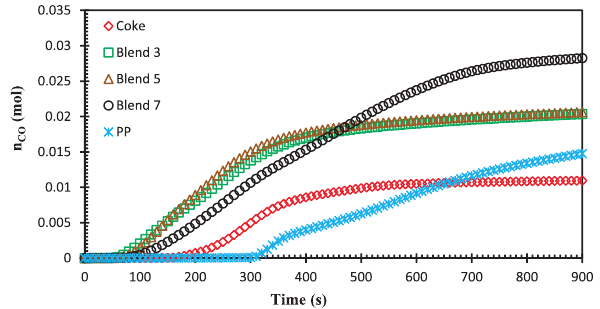
Fig. 7: Comparison of the amounts of CO generated by coke, PP and coke-PP blends at 1500